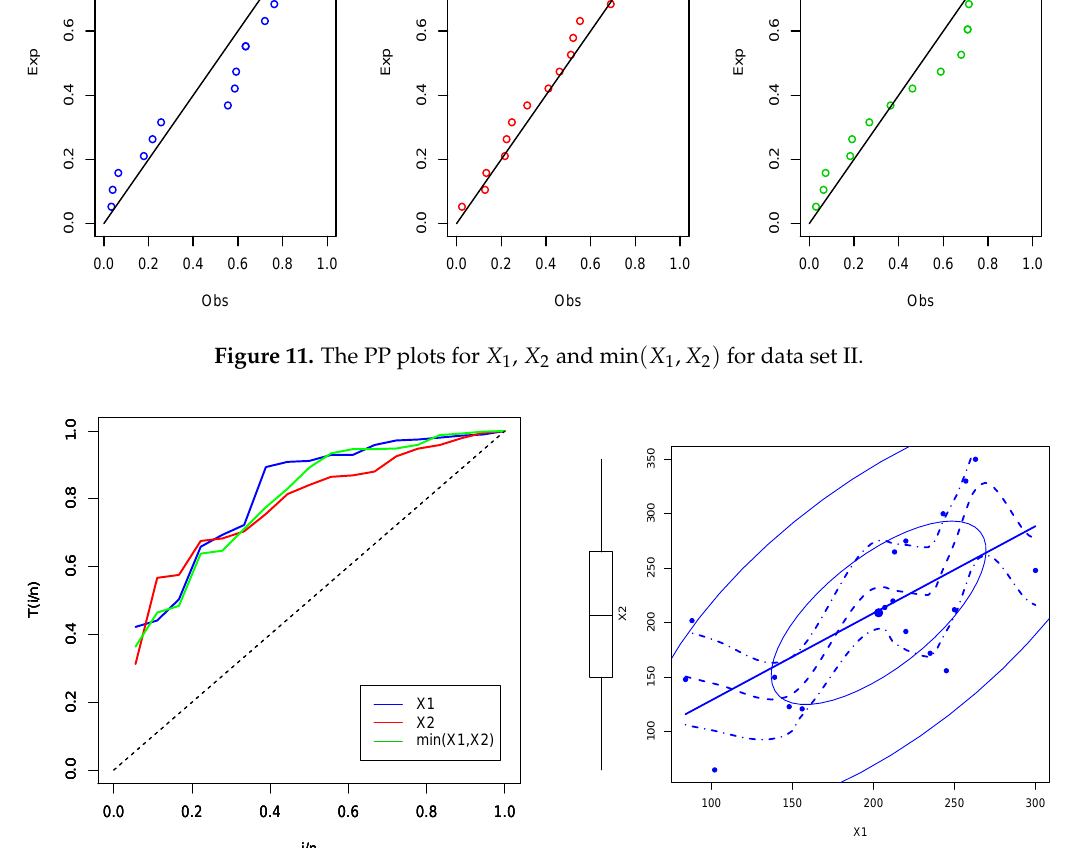
Figure 12. The TTT (left panel) and scatter (right panel) plots for data set II.